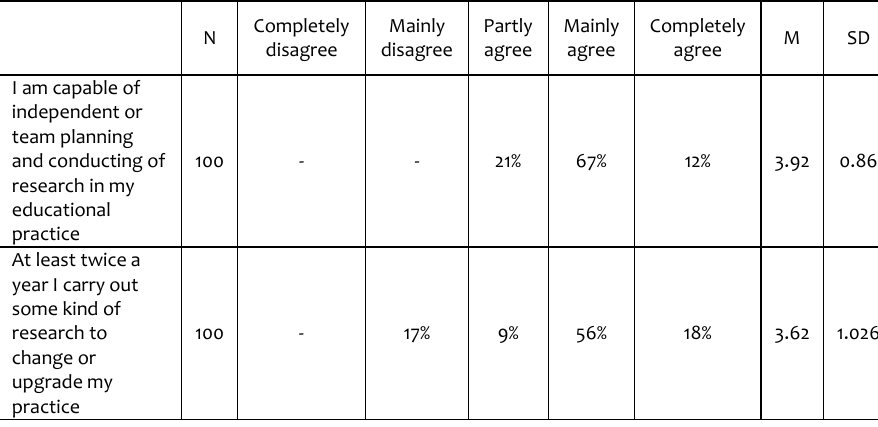
Table 3: Research work of